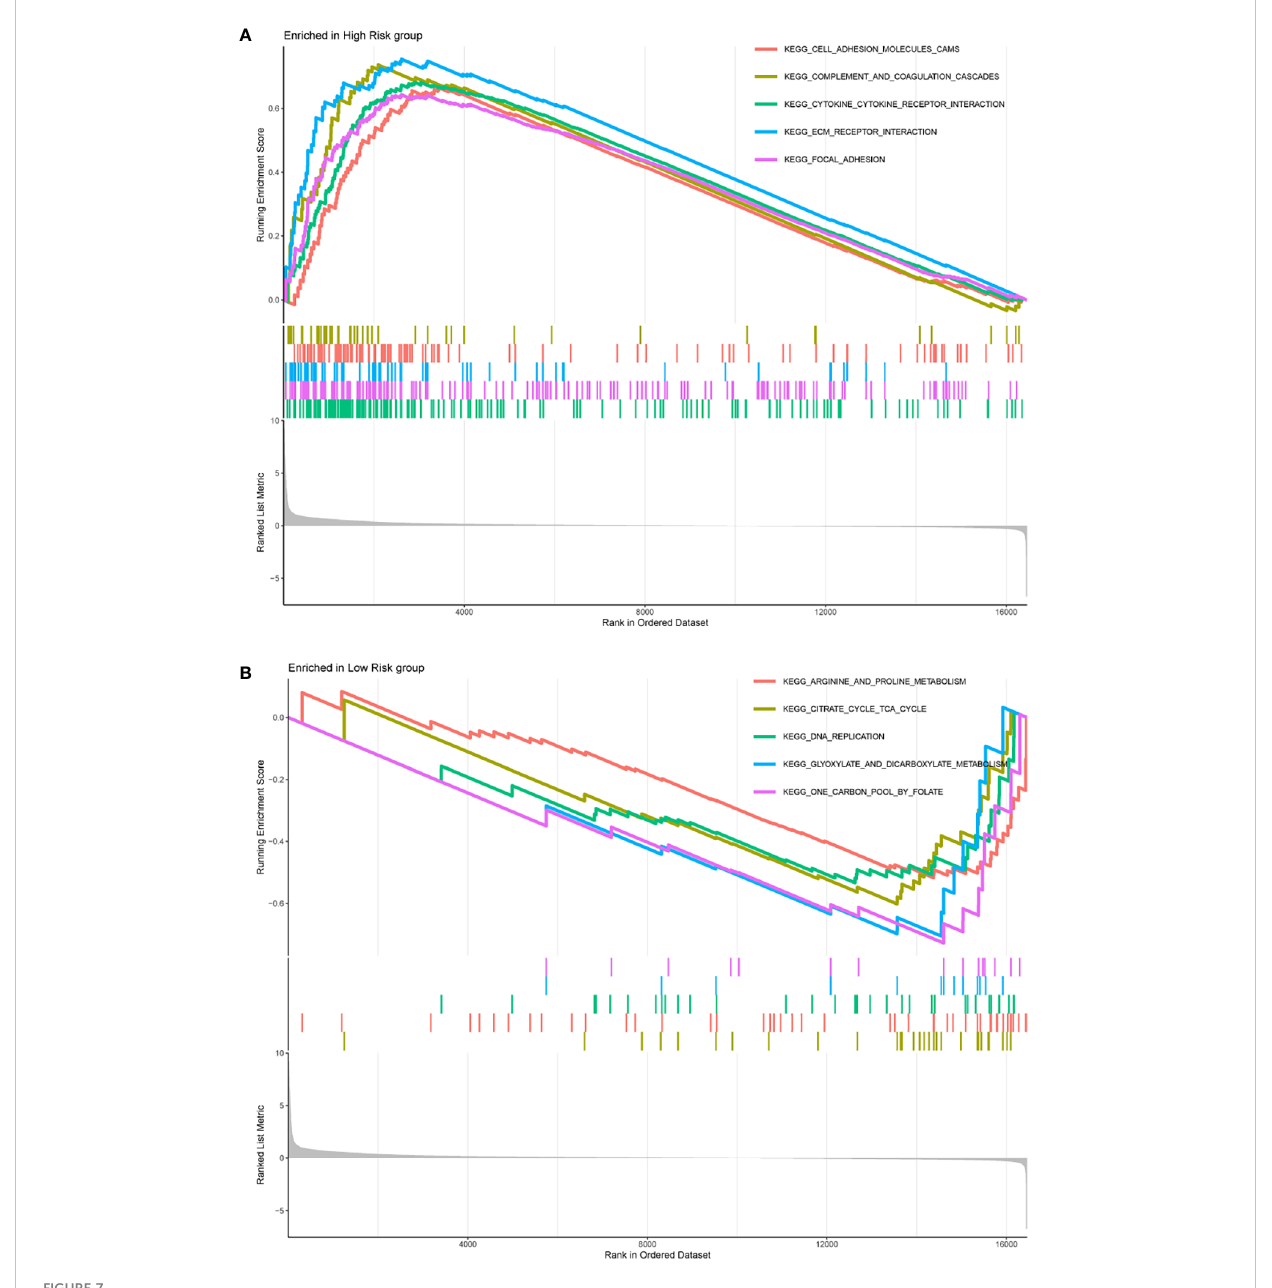
FIGURE 7 The top fi ve signaling pathways enriched in high-risk group (A) and low-risk group (B) were shown by GSEA analysis,